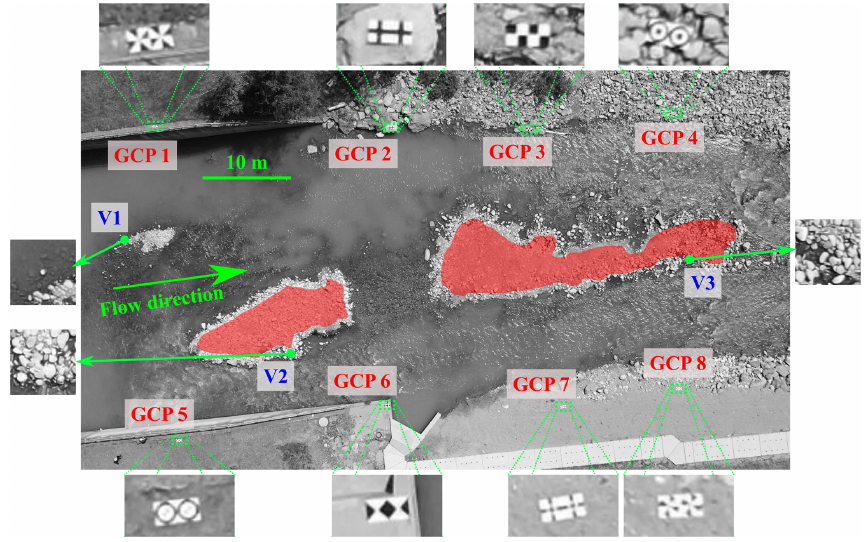
Figure 5. Region of interest and the distribution of ground control points for case study 2 (Alpine river). Red coloured regions are later used for displacement analysis, using surface velocity fields (SVFs), in Sect.